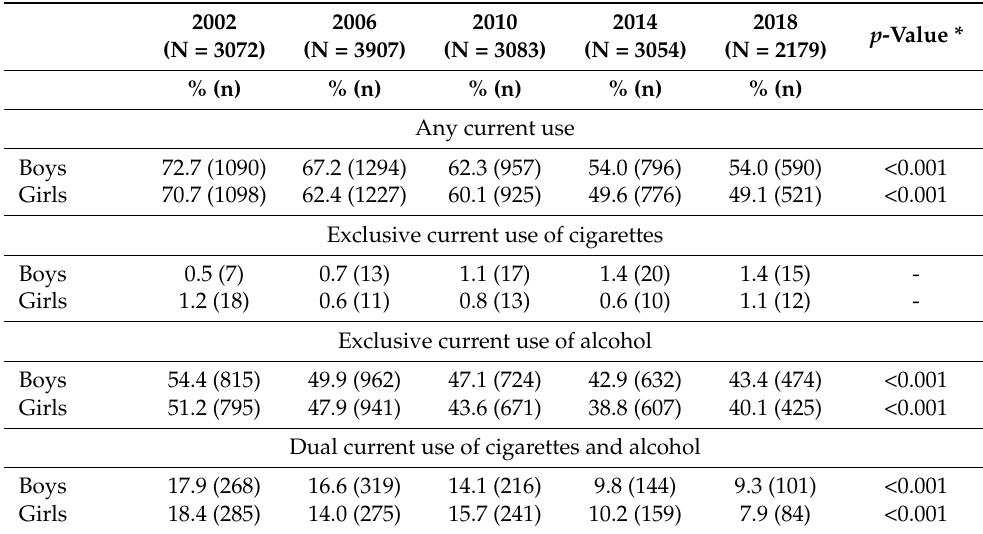
Table 4. Current substance use at five time points, 2002–2018, according to gender.